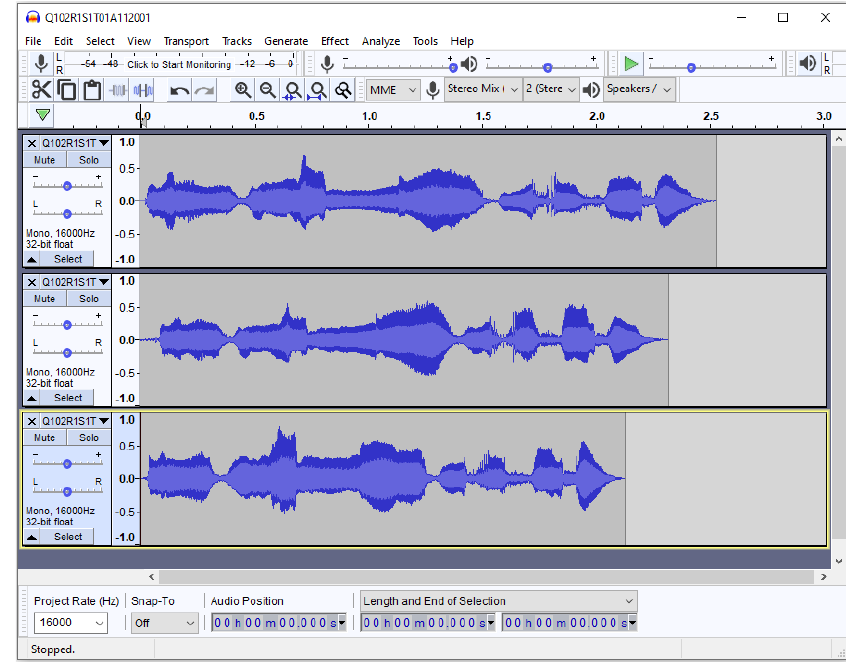
Figure 3. Using the Audacity program for recording and pre-processing.